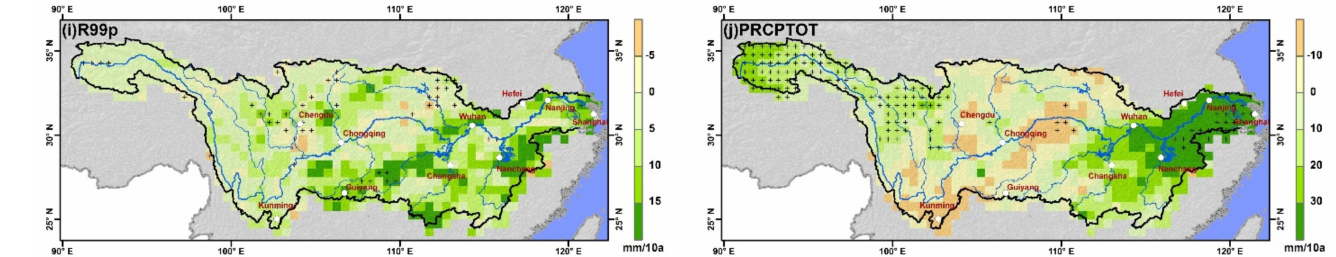
Figure 4. Spatial trend distribution of extreme precipitation and temperature indices from 1961 to 2020: ( a ) TXx; ( b ) TXn; ( c ) TNx; ( d ) TNn; ( e ) DTR; ( f ) SDII; ( g ) Rx1day; ( h ) Rx5day; ( i ) R99p; ( j ) PRCPTOT. Significant positive trend or negative trend at the 0.01 significance level was indicated by